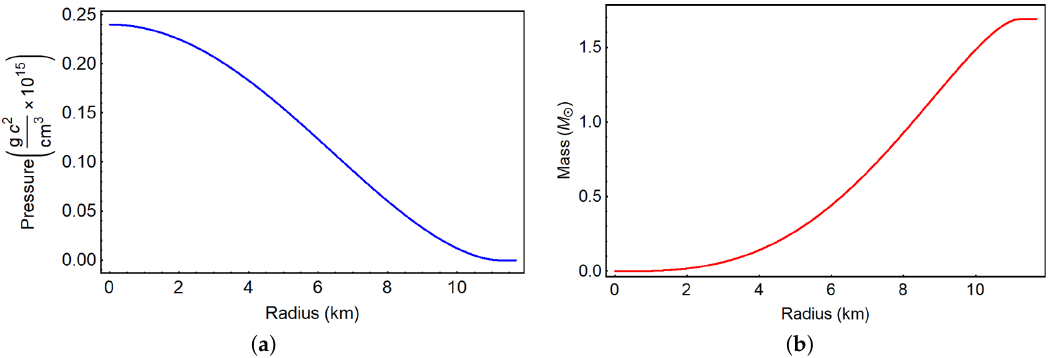
Figure 1. ( a ): Pressure vs. radial distance and ( b ): enclosed mass vs. radial distance for the Skyrme (Model A) equation of state. These curves both correspond to the same star with a central density of